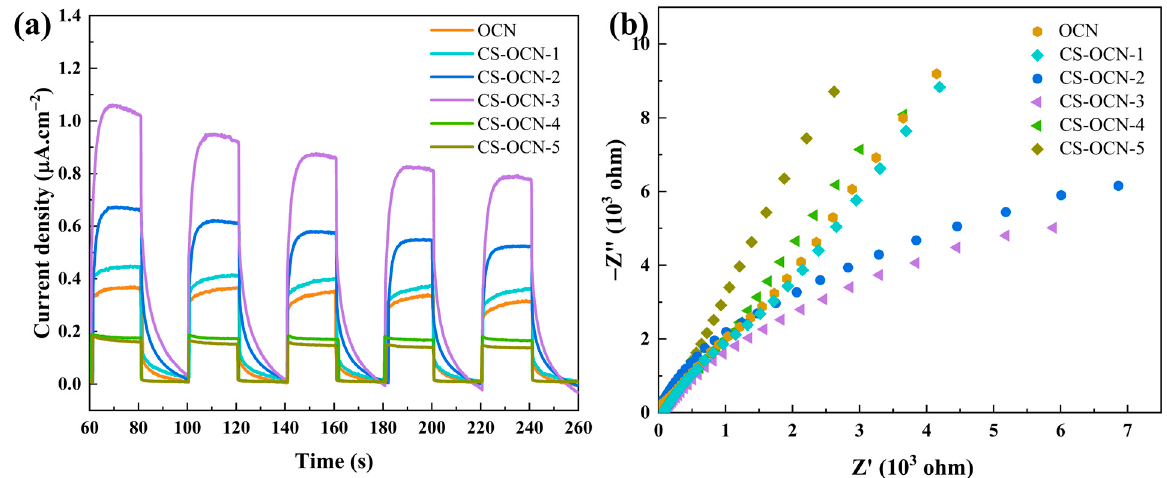
Figure 9. ( a ) Photocurrent responses and ( b ) EIS curves of OCN and CS-OCN.